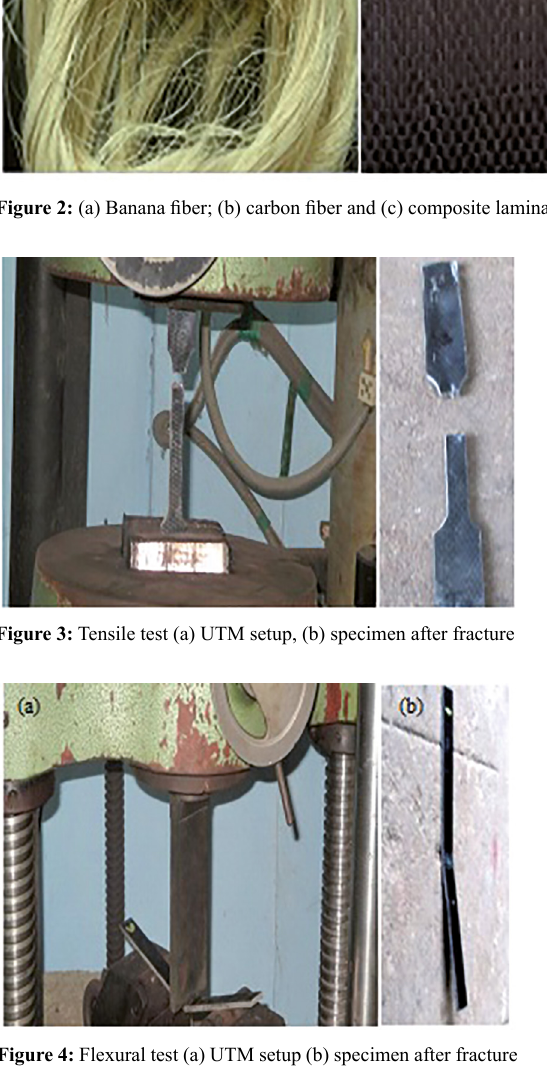
of banana/carbon fibers reinforced epoxy composites are presented in Figure 5.